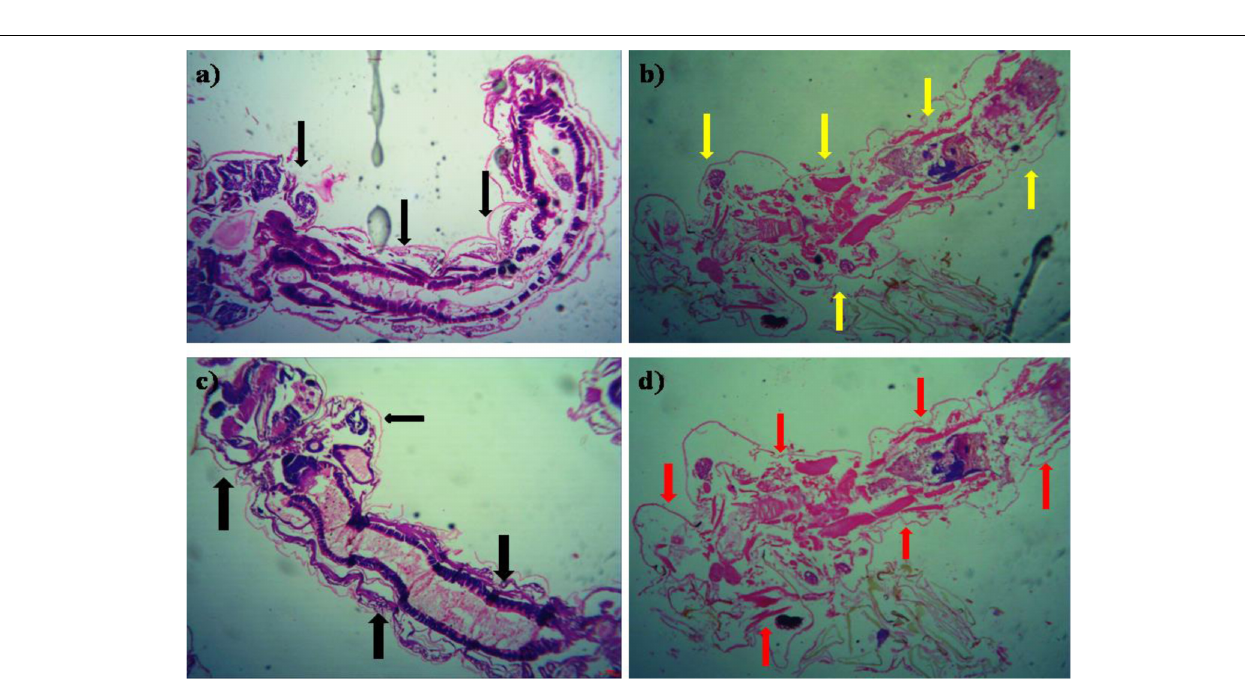
FIGURE 4 | Histopathological study on treated third instar larvae of Ae. aegypti and Cx. quinquefasciatus : Control (a–d) treated with the P. daleae mycelium ethyl acetate extract, Black arrow represents control larvae structures, yellow and red arrow indicates the disordered and broken epithelial cell layer, complete breakup of mid-gut and caeca and collapsed larval structure,